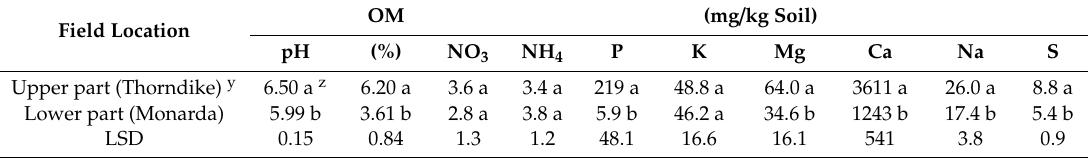
Table 1. Selected soil chemical properties and nutrient concentrations in Spring 2017 at the field study site (with di ff erences noted between upper and lower parts of the field) in St. Albans,